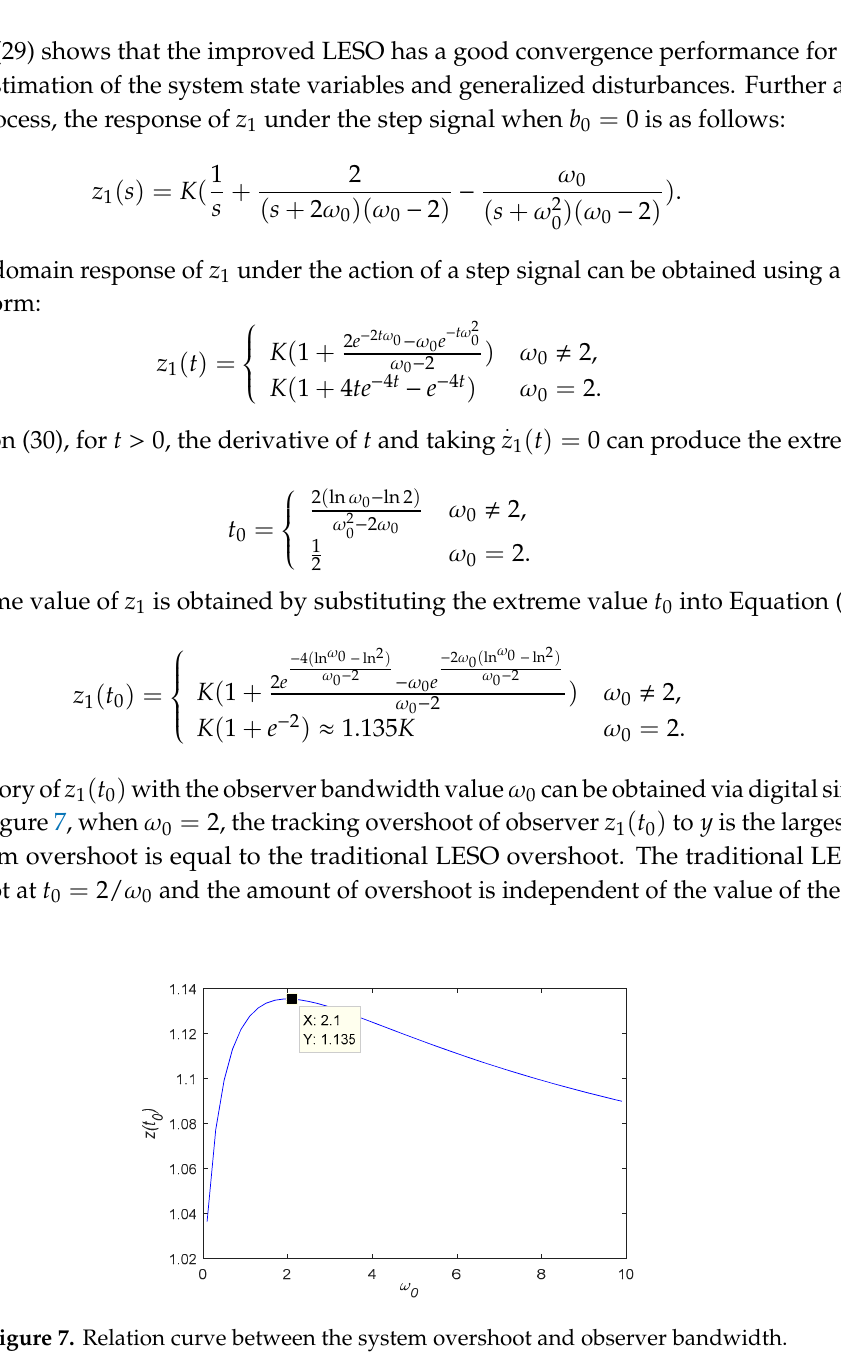
Figure 7. Relation curve between the system overshoot and observer bandwidth.